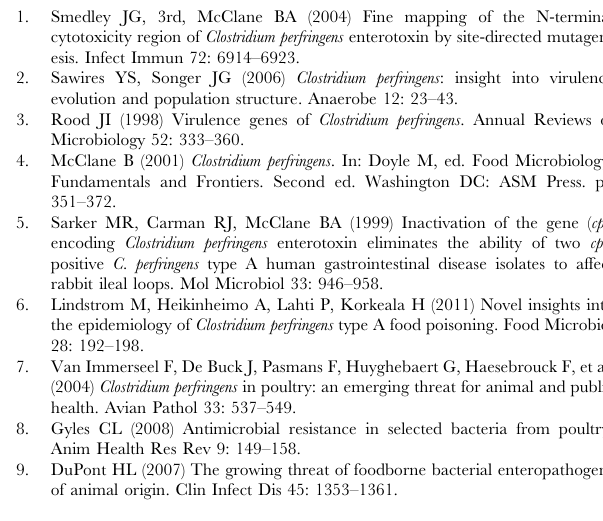
Figure S3 Restriction Endonuclease Maps for the Genomes of Bacteriophages W CPV4, W ZP2 and W CP7R and Terminal Protein Detection. A) Eco RV and Eco 91I maps for all three bacteriophages based on genome nucleotide sequences. B) Electropherogram of W CPV4 genomic fragments Eco RV without protease digestion (lane 2). Arrows indicate terminal genome fragments. Table S1 Open Reading Frames for the W CPV4 Ge- nome. Table S2 Open Reading Frames for the W ZP2 Genome. Table S3 Open Reading Frames for the W CP7R Ge- nome. Table S4 Purified Bacteriophage Protein Mass Spec- trometry Proteomics